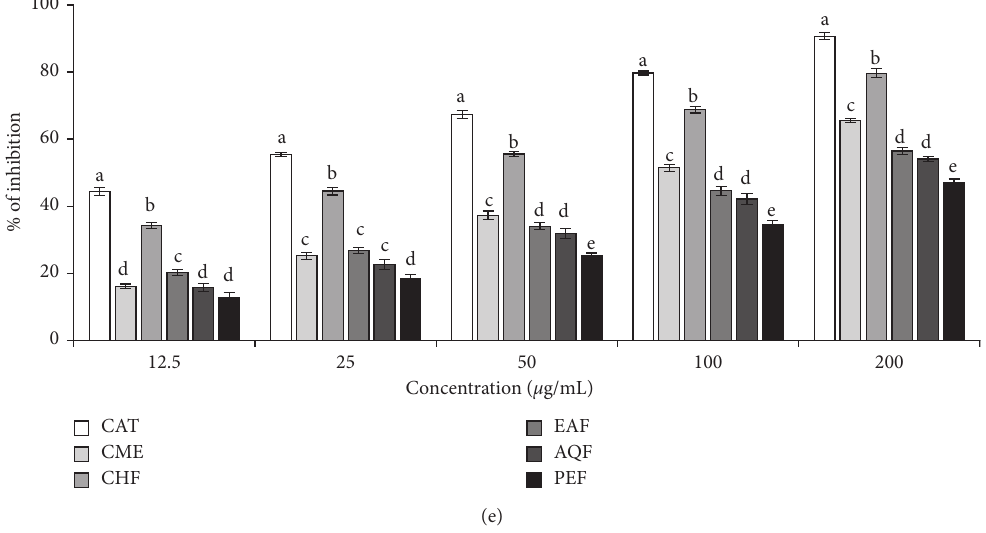
Figure 4: Antioxidant activity of CME of S japonica and its fractions . (a) DPPH radical scavenging activity. IC 50 ( µ g/mL): CAT, 3.03 ± 0.15; CME, 24.12 ± 1.00; CHF, 5.01 ± 0.16; EAF, 19.10 ± 0.73; AQF, 44.57 ± 1.90; PEF, 48.48 ± 3.47. (b) Hydroxyl radical scavenging activity. IC 50 ( µ g/mL): CAT, 9.00 ± 0.34; CME, 97.24 ± 1.09; CHF, 17.12 ± 0.23; EAF, 56.67 ± 0.63; AQF, 86.08 ± 1.88; PEF, 162.00 ± 1.76. (c) Ferric reducing power. At 100 µ g/mL concentration, the absorbances are as follows: CAT, 2.539 ± 0.045; CME, 1.471 ± 0.027; CHF, 2.489 ± 0.039; EAF, 1.548 ± 0.033; AQF, 0.627 ± 0.020; PEF, 0.609 ± 0.014. (d) Total antioxidant capacity. At 100 µ g/mL concentration, the absorbances are